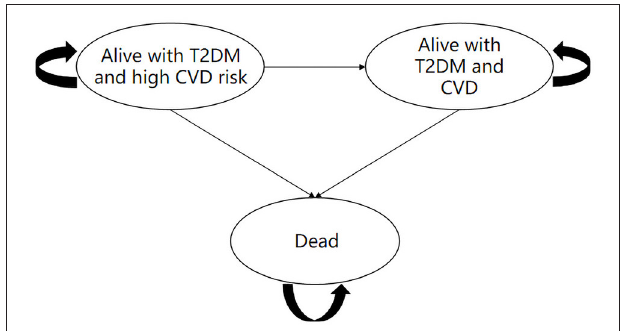
FIGURE 1 | Diagram of the Markov state transition model and health states of dapagliflozin plus standard vs. standard treatment. T2DM, type 2 diabetes mellitus; CVD, cardiovascular